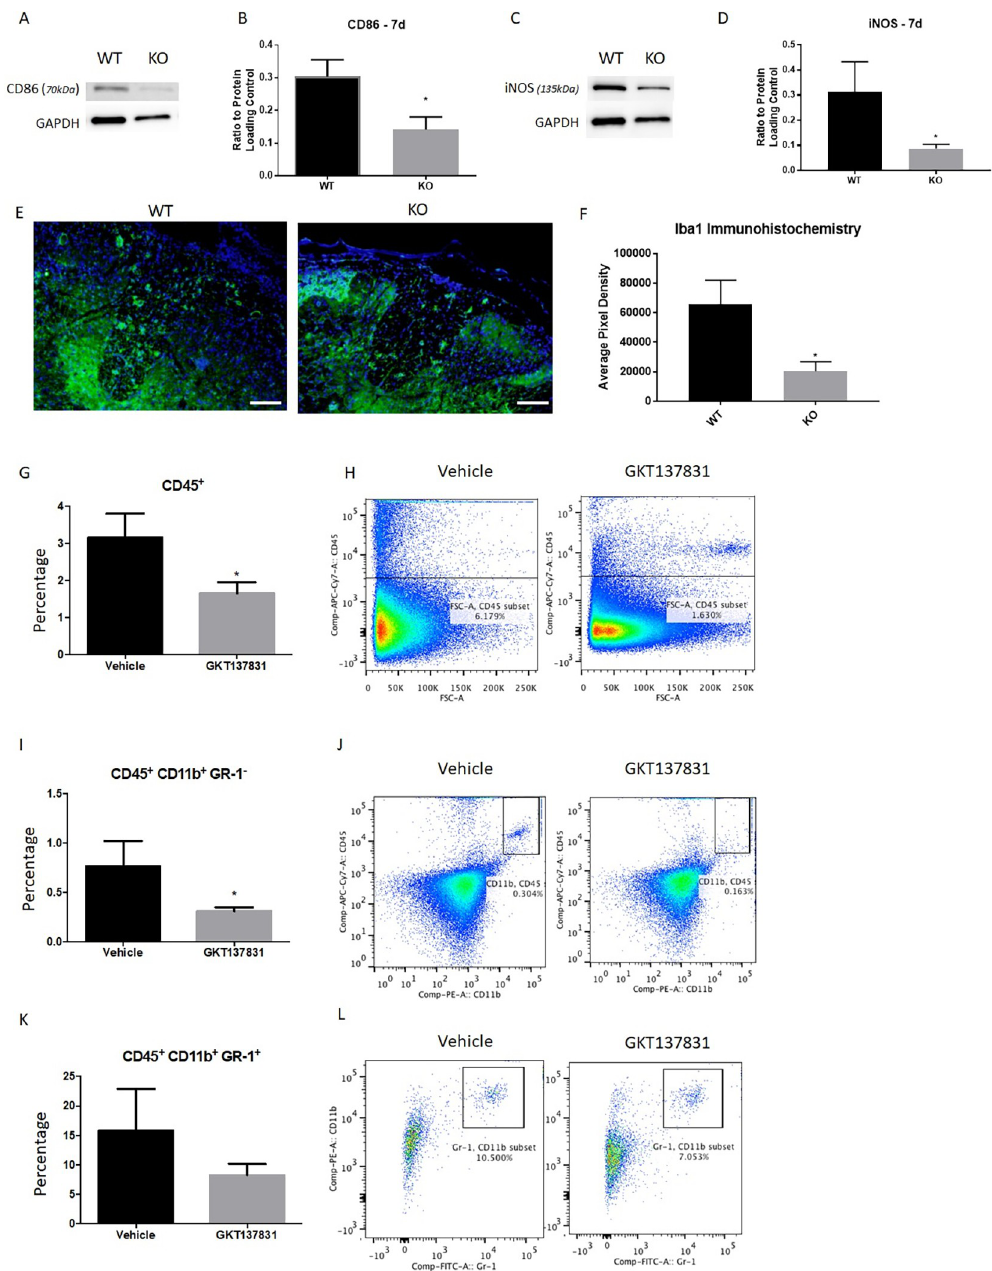
Fig 3. Markers of inflammation were significantly reduced at 7dpi by NOX2 and NOX4 inhibition, but remained so only with NOX2 KO at 28 DPI. Western blotting for inflammatory markers CD86 (A, B) and iNOS (C, D) were significantly altered by NOX2 KO at 7dpi. GAPDH was used to normalize data. N = 4/group. Iba1 immunohistochemistry showed a continuation of inflammation depression with significant reduction at 28 DPI as measured by threshold pixel density analysis (E, F). Images shown 1.5mm rostral to the lesion epicenter. N = 4/group. Size bar = 200 μ M. Flow cytometry was performed on tissue at 7 DPI to measure inflammatory cell populations in vehicle or GKT137831 treated spinal cords. All inflammatory cells were marked with CD45 + and showed a significant reduction with GKT137831 treatment (G, H). CD45 + CD11b + GR-1 - were interpreted as the macrophage/microglia population and showed a significant reduction (I, J). CD45 + CD11b + GR-1 + were used to identify the neutrophil population and GKT137831 induced no significant change in these cells (K, L). N = 6-7/group. � p < 0.05, unpaired t-test. Bars represent mean +/- SEM.